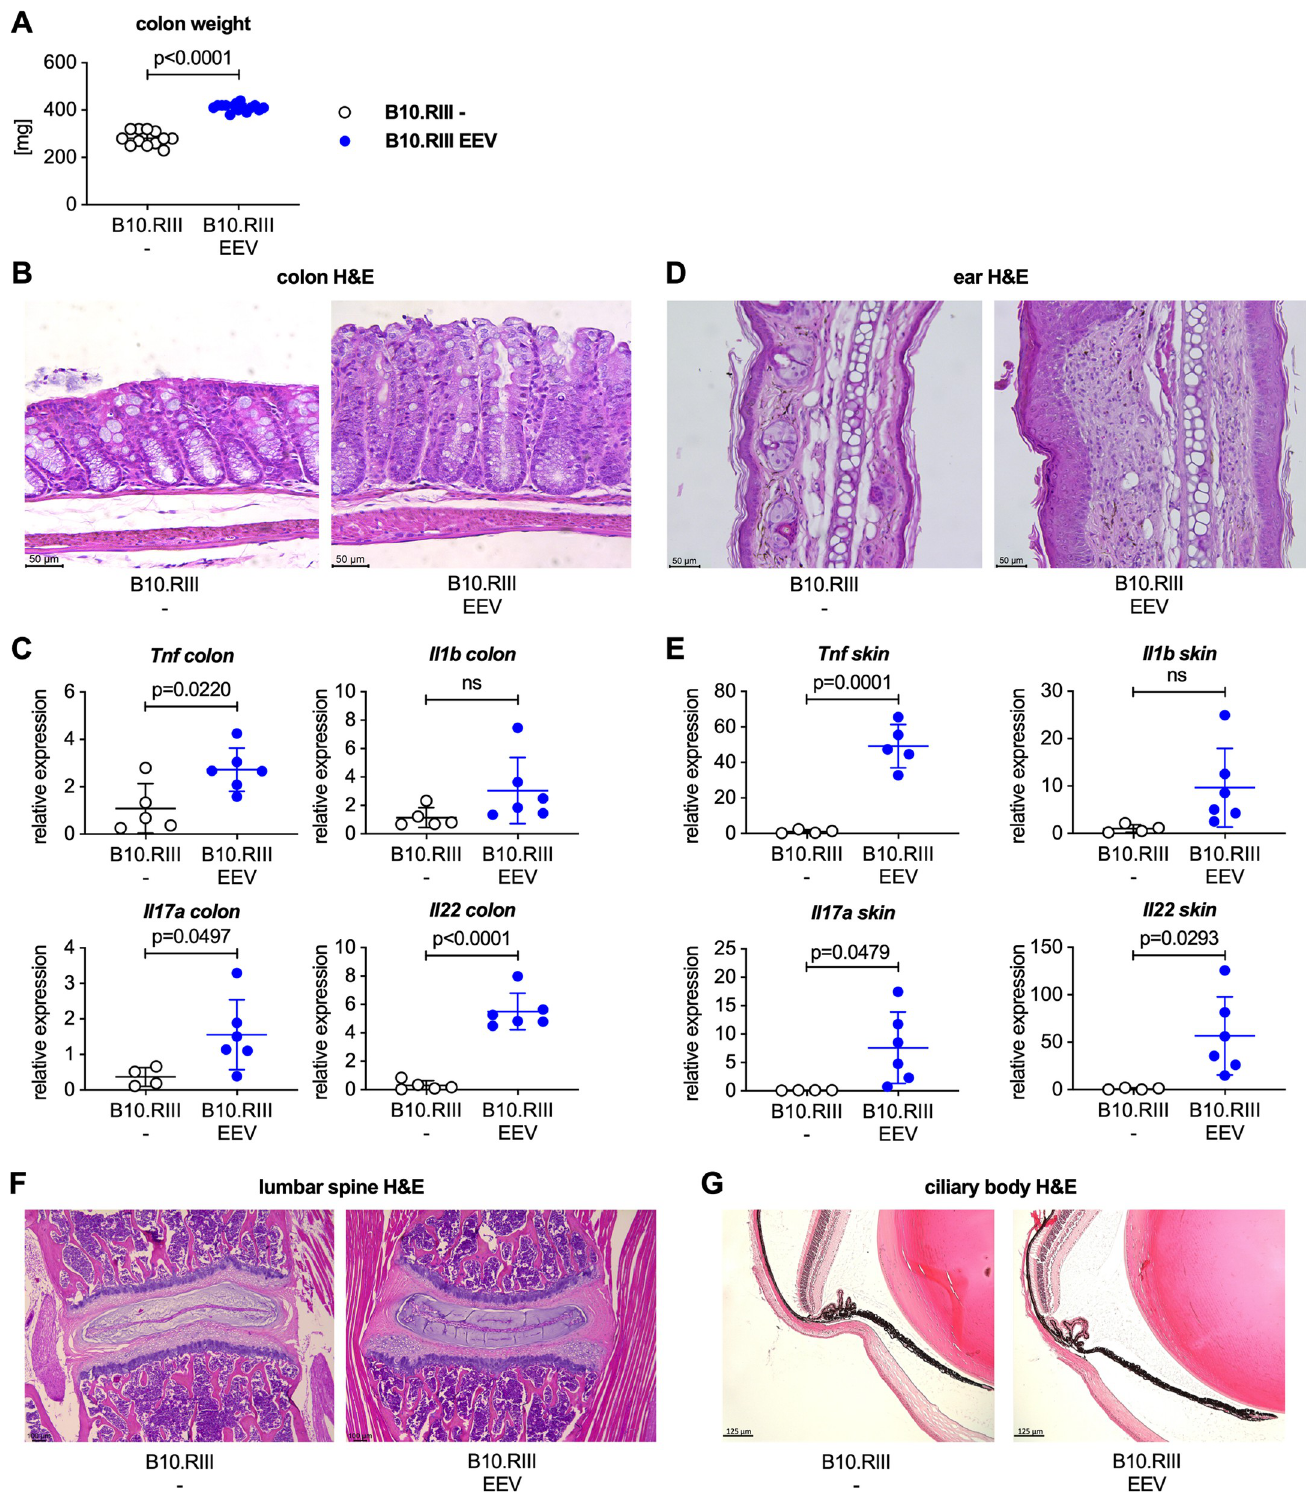
Fig 2. Male B10.RIII mice injected with IL-23 EEV develop colitis and psoriasis-like skin disease but not spondylitis or uveitis. (A) Colon weight of the animals in the experiment shown in Fig 1. (B) Representative H&E stained colon sections from control and IL-23 EEV injected mice, scale bar 50 μ m. (C) Expression of Tnf , Il1b , Il17a , and Il22 in the colon was analyzed by qPCR (n = 5–6 mice/group). (D) Representative H&E stained sections of day 14 ears from control and IL-23 EEV